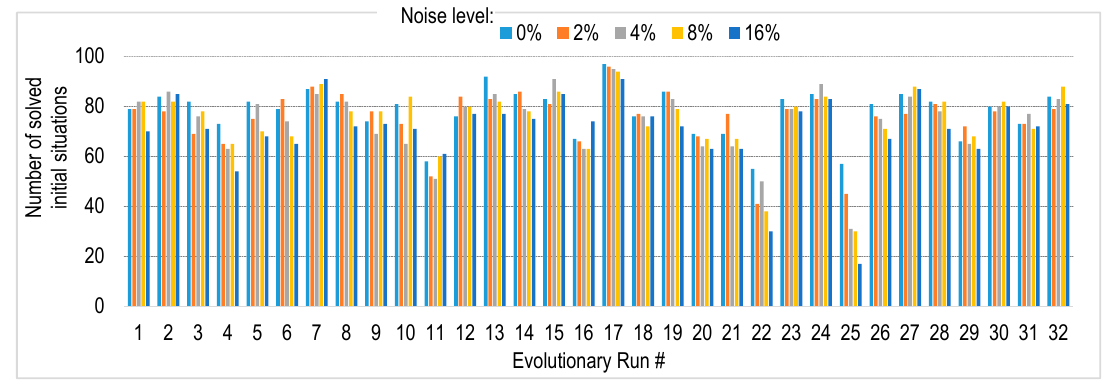
Figure 6. Number of successfully solved initial situations for various levels of false positive (FP) perception noise.